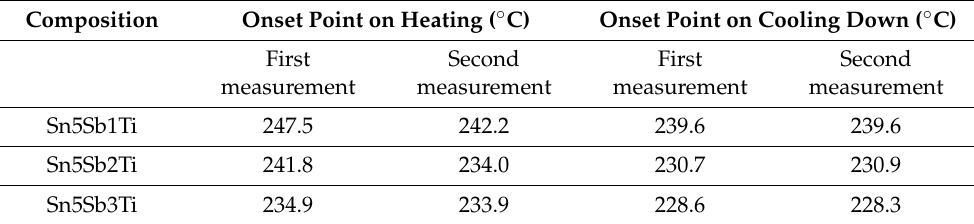
Figure 8 . Binary system of tin–antimony [38] . The red line indicates the chemical composition of the Sn5Sb base solder .